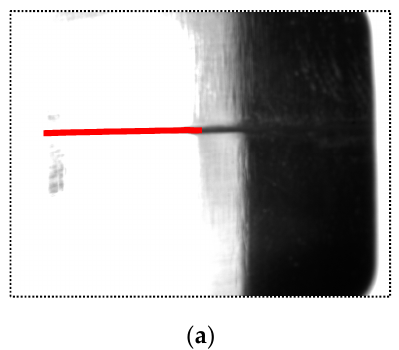
Figure 20. Image processing results. ( a ) Image processing results of Figure 19k; ( b ) Image processing results of Figure 19d.